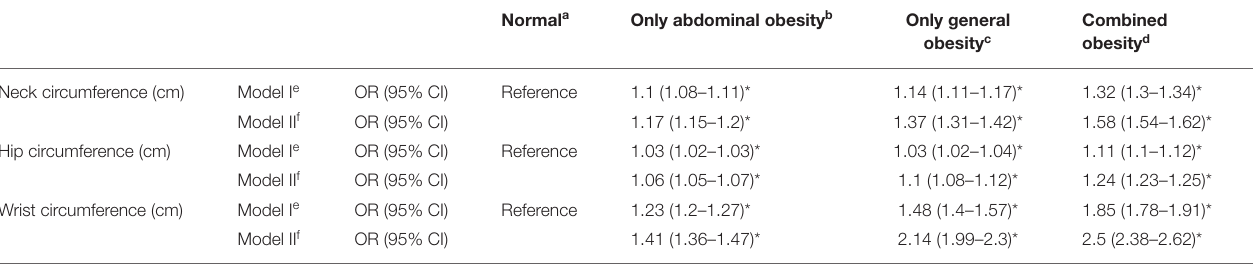
TABLE 4 | Association of neck, hip, and wrist circumference with general, abdominal, and combined obesity in a multinomial logistic regression model.